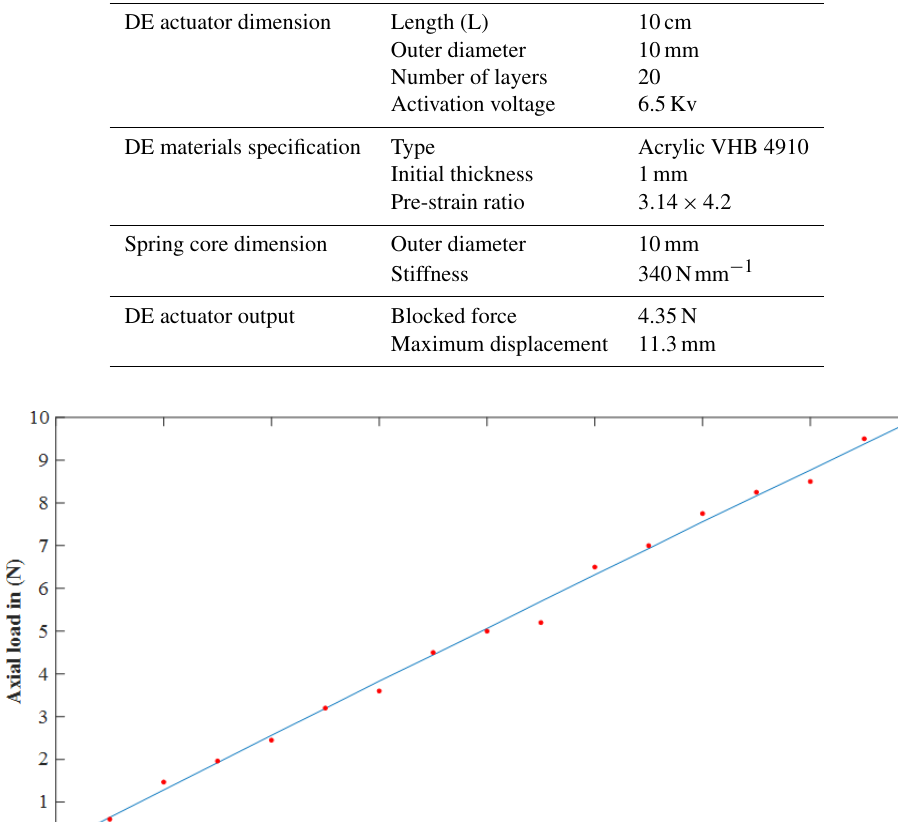
tact with the electrode layer. Then wrapped manually around a compressed spring as shown in Fig.